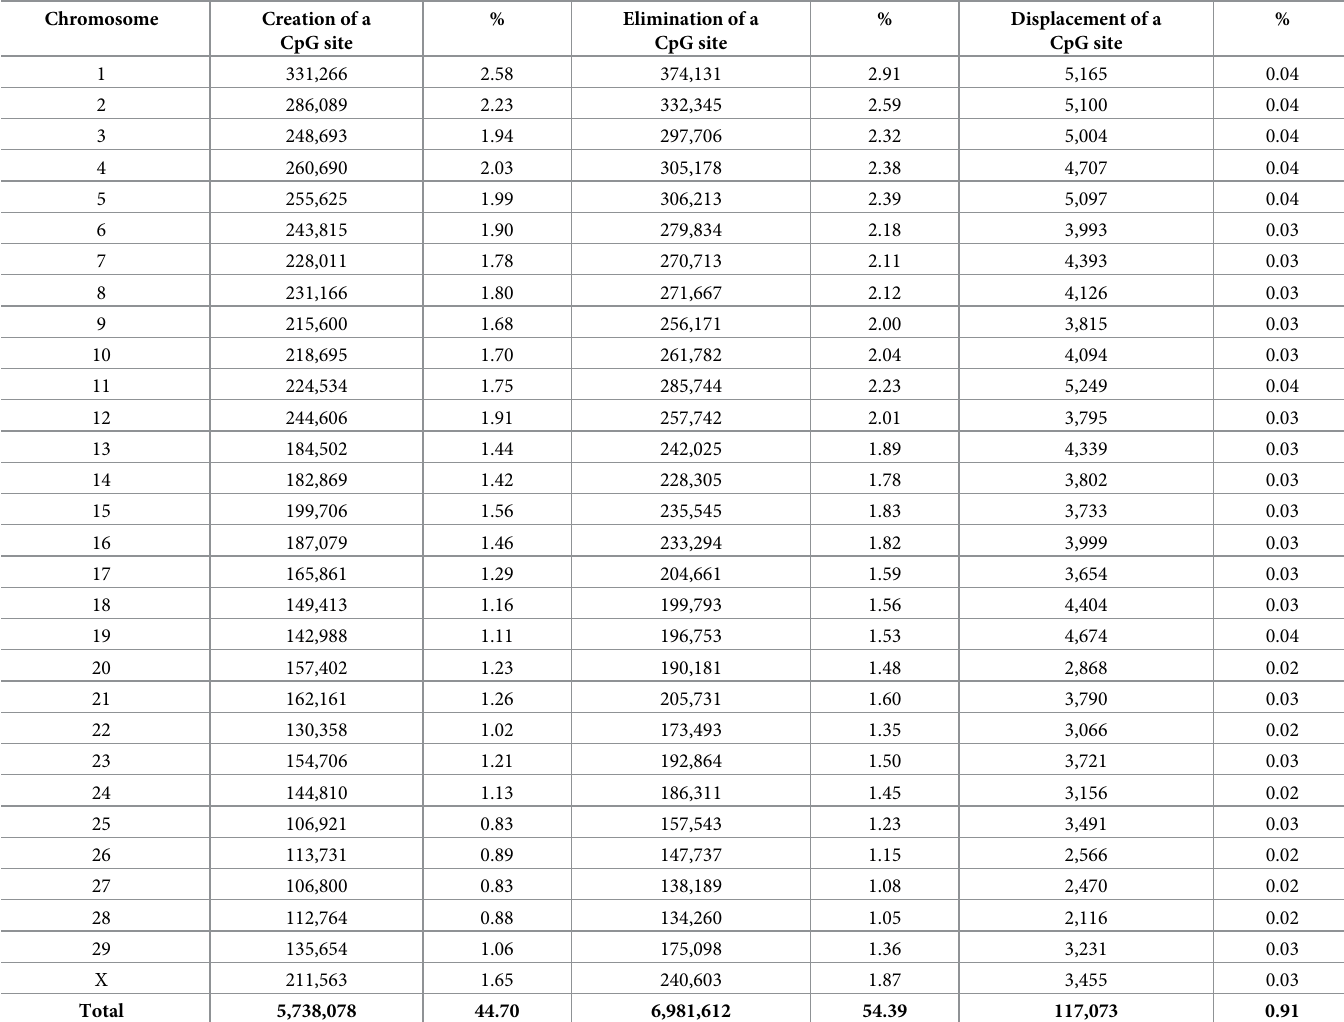
Table 1. Characterization of meSNPs according to the variant pattern created at a CpG